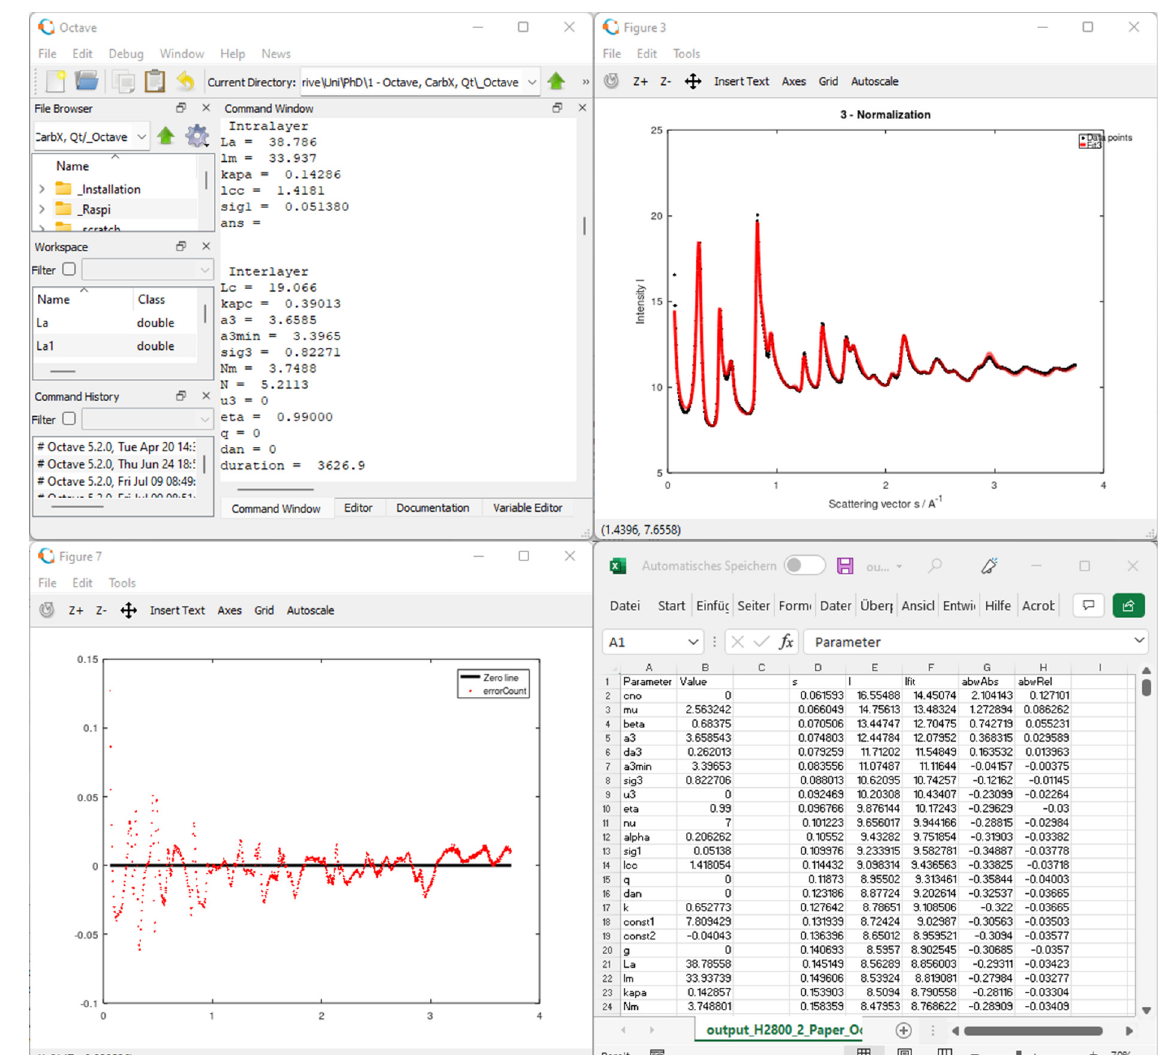
Figure 4. Results of the wide-angle neutron scattering (WANS) refinement using OctCarb (upper left): In addition to the microstructural parameters in text form categorized by interlayer and intralayer parameters, Octave plots the measurement data and the fit as well as the deviation, and saves all in a CSV file.